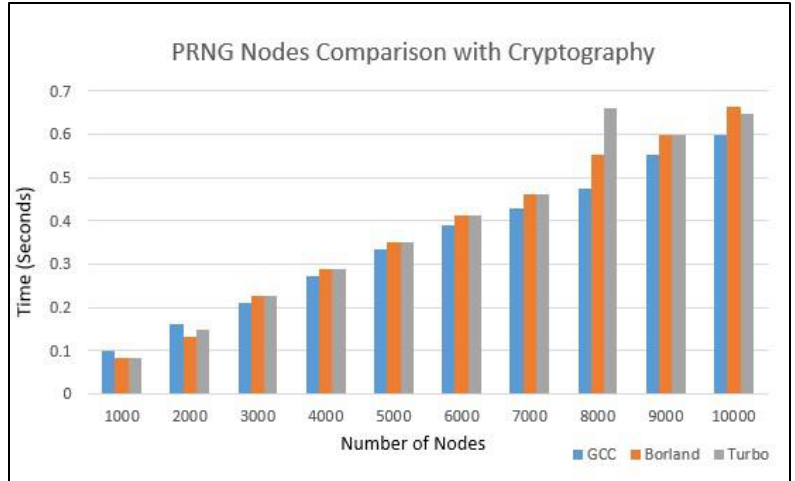
15 of 19 Figure 7. Protocol total time analysis and comparison within the ( a ) mobile workstation, ( b ) IoT device 1, and ( c ) IoT device 2. Figure 8 shows the comparison of different PRNG parameter settings for the auton- omous-protocol-based authentication for the nodes from 1000 to 10,000. As the pseudo- random numbers used here are highly variable in their numerical range, it can be ob-